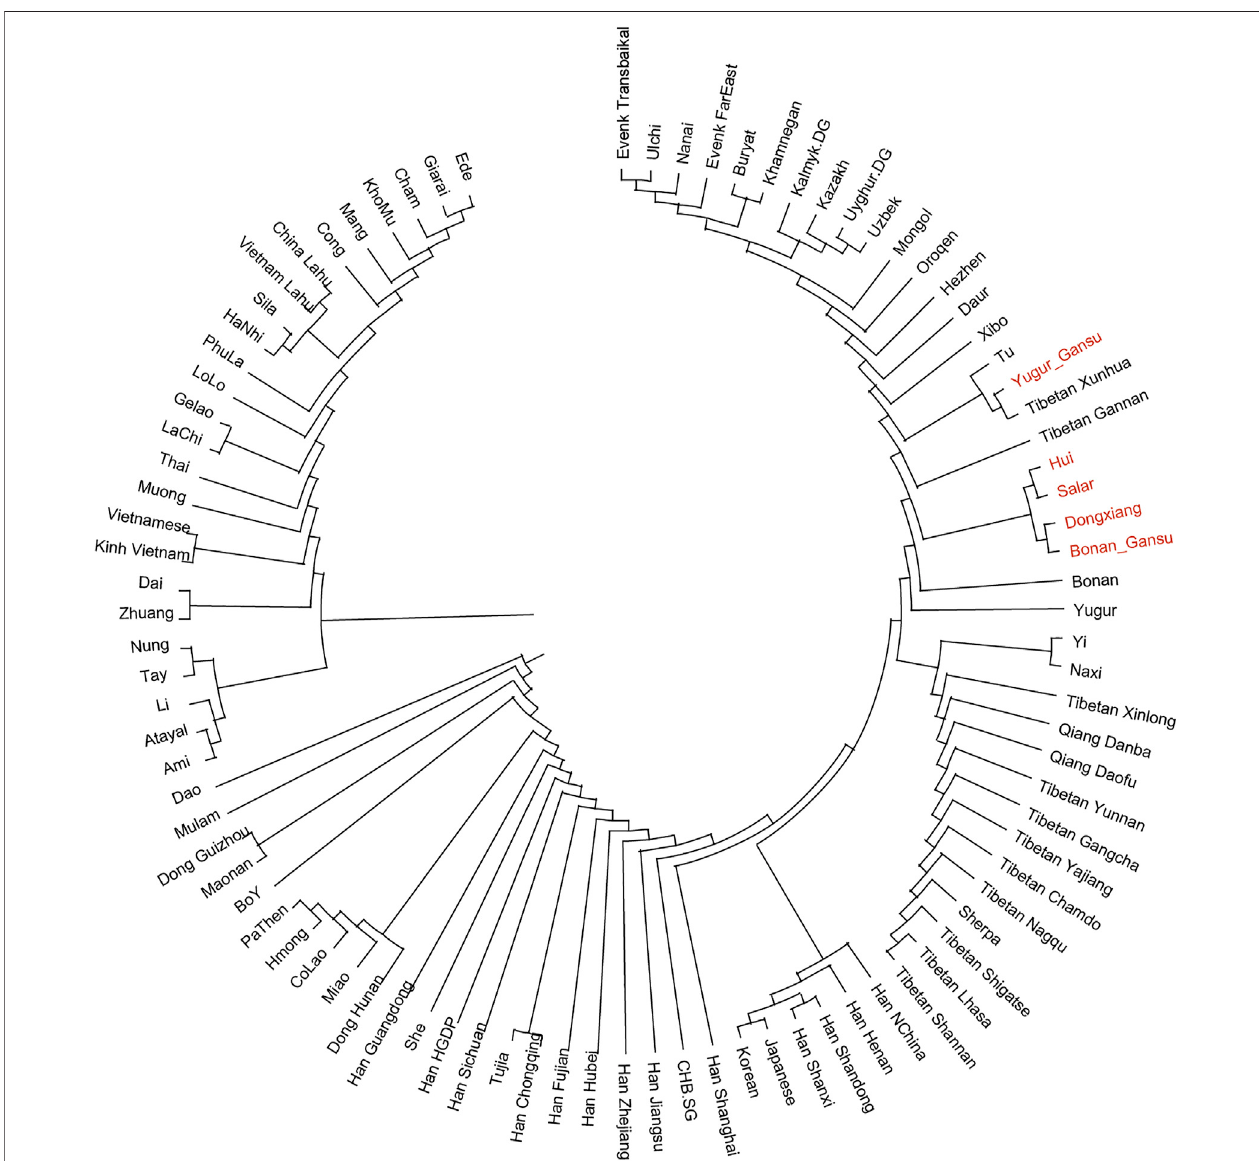
FIGURE 5 | Phylogenetic tree among our studied populations in Gansu and reference populations in Eurasia. Our samples in Gansu province were marked with red color.